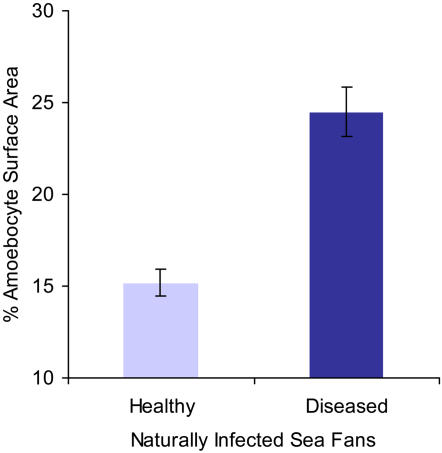
Quantitative analysis of amoebocytes in mesoglea of sea fan corals showing a dramatic increase in amoebocytes in diseased coral tissue.% surface area covered by amoebocytes calculated from histological images of mesogleal tissue sampled from uninfected sea fans and mesogleal tissue adjacent to fungal infections in diseased sea fans. Data presented are mean±s.e.m, n = 8 , X
2 28.93, p<0.0001.